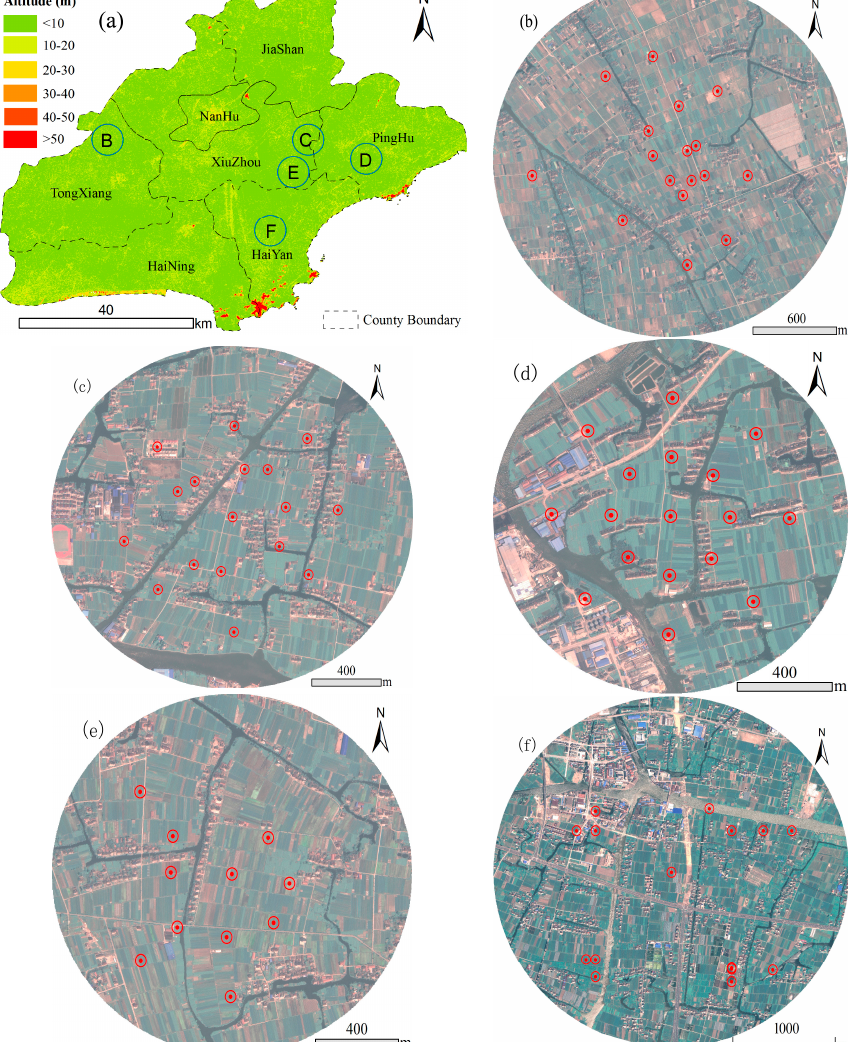
Figure 1. Map of the study area in the Jiaxing Prefecture of East China where ( a ) Is showing the positions of the five study sites identified by a density within the circles ( b – f ); respectively indicate the landscape structures of five study sites with pan-sharpened multispectral (Red: Green: Blue) GeoEye-1 satellite imageries including TongXiang, XinFeng, PingHu, XinHuang, and HaiYan. The dashed line indicates the district administrative level boundary in ( a ). The red circles show the sampling plots of Laodelphax striatellus in ( b – f